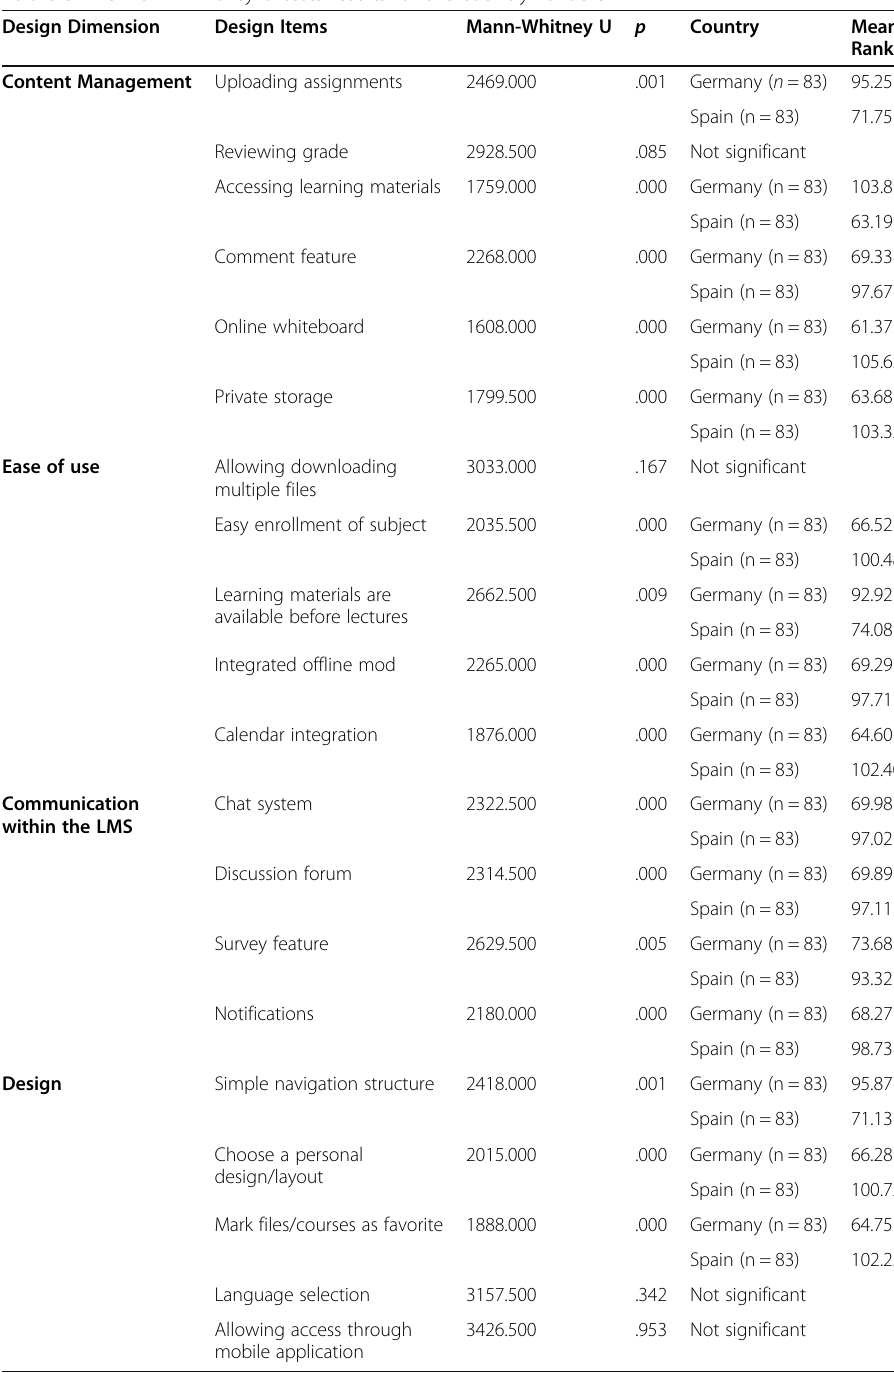
Table 5 The Mann-Whitney U tests results for the country variable Design